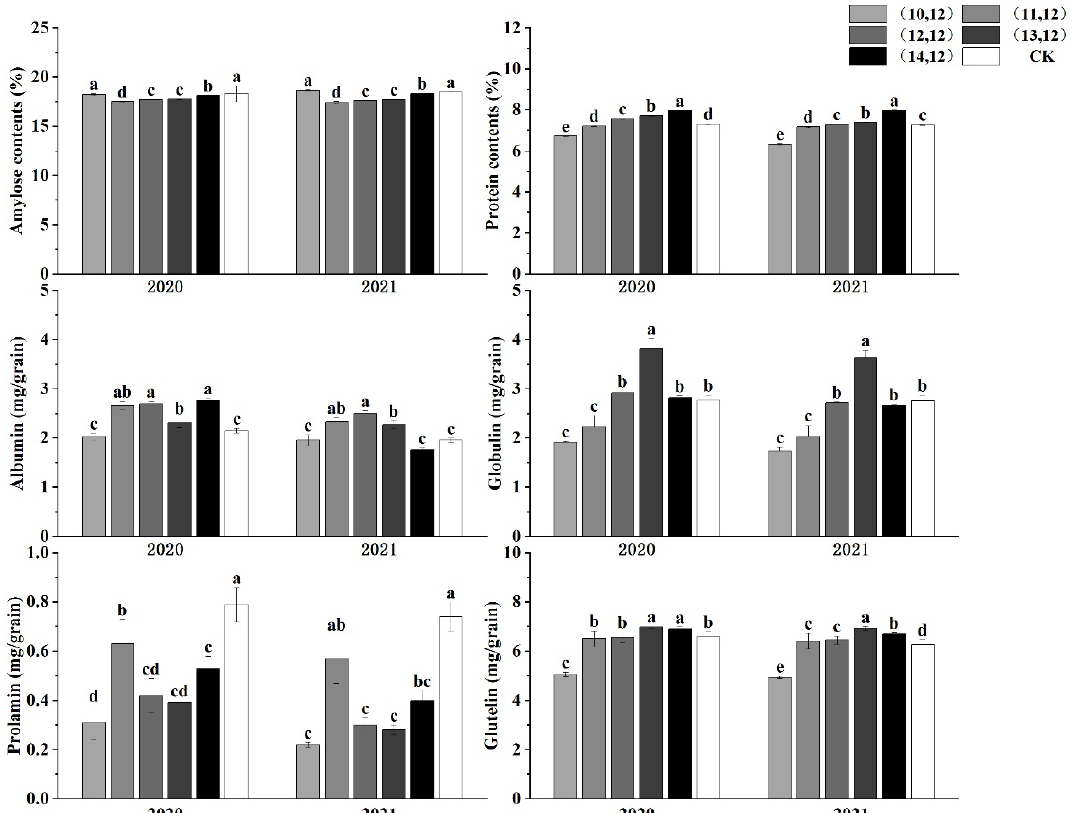
Figure 4. Effects of N and K application on rice amylose, protein component at different leaf ages patterns in 2020 and 2021, with the results of the two-factor ANOVA. The (10, 12), etc., represent the patterns of different applications of N and K at the panicle stage; CK is the fertilization pattern of local farmers. Error bars indicate standard errors of three replicates. Different lowercase letters above the columns indicate significant differences ( p < 0.05) among different panicle fertilizer application patterns in the same year. Table 4. Effects of different N and K combined application rates during the panicle stage on rice amylose and protein components in 2020 and 2021, with the results of the three- way ANOVA.